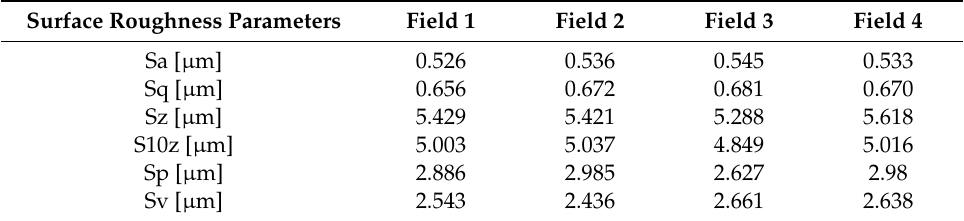
Table 3. Area-based surface roughness parameters of the four fields from Figure 8.